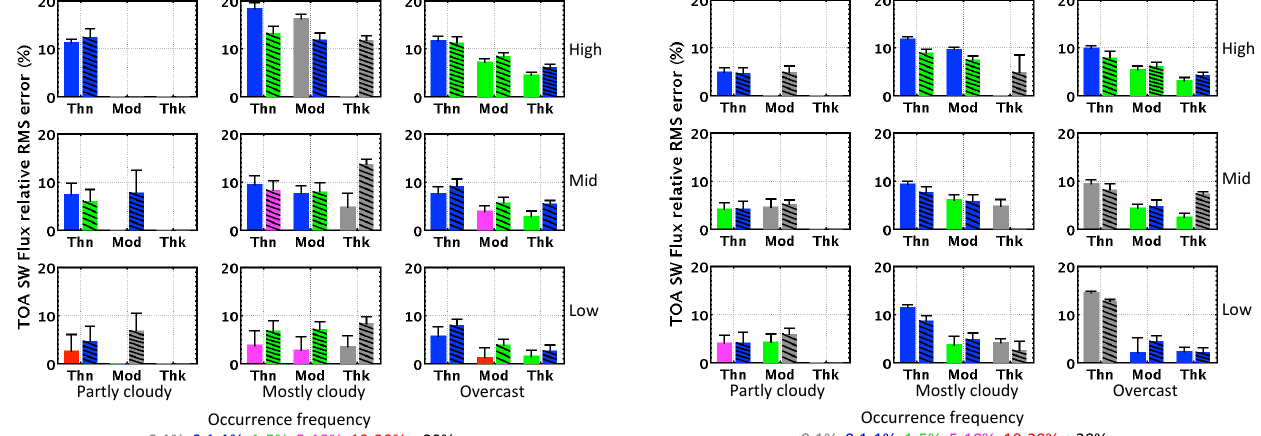
Figure 15. TOA SW flux consistency (%) among the MISR camera angles for different cloud types over ocean. The height of the bar shows the flux consistency due to ADM uncertainties, and the error bar shows the contribution of narrowband-to-broadband regression to the total consistency. The left bars are for single-layer clouds, and the right bars (hatched) are for multiple-layer clouds. The color of the bar indicates the occurrence frequency for each cloud type.